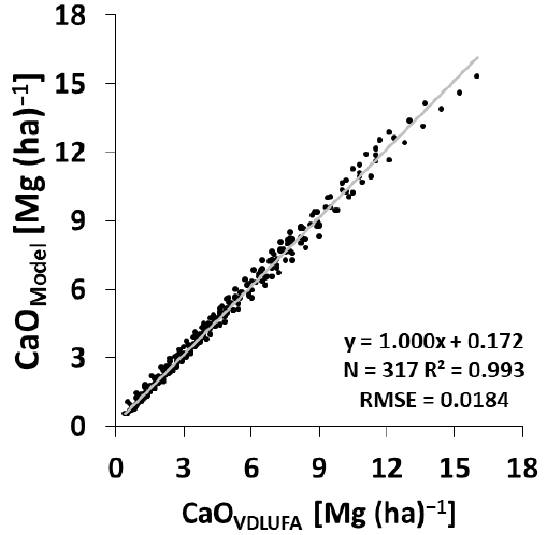
Figure 8. CaO amounts necessary to increase the pH value from a suboptimal range (lime supply statuses A and B) to the optimum pH range (lime supply status C), as recommended by the VDLUFA approach (CaO VDLUFA , see Figure 3), in comparison to the CaO amounts predicted by the stepless approach (CaO Model ).